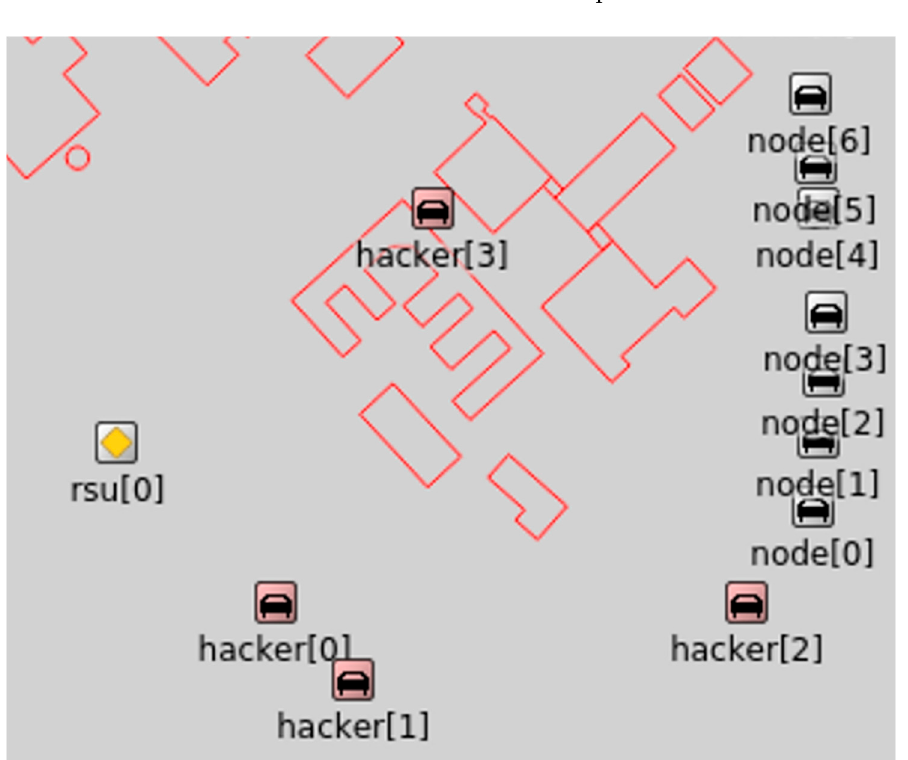
Figure 10. Veins/OMNET++ attacker simulation environment.